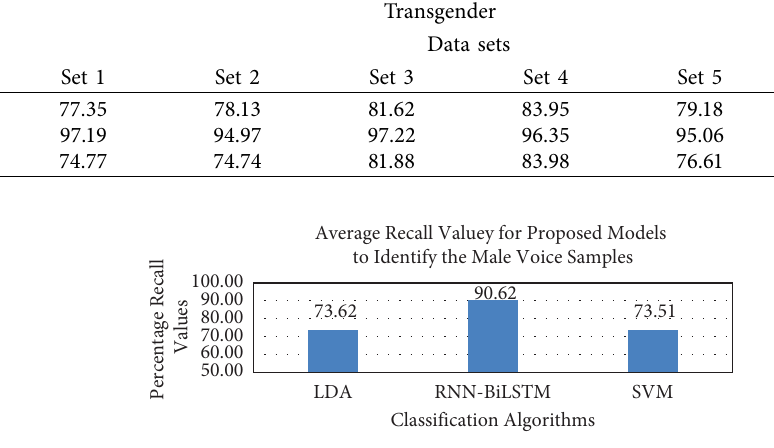
Figure 3: Average recall value for proposed models to identify the male voice samples.